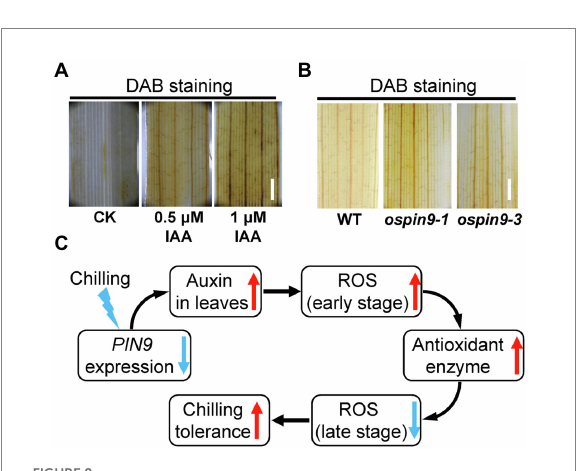
FIGURE 8 Effects of auxin application on the production of H 2 O 2 and the proposed model of OsPIN9 -mediated chilling tolerance in rice. (A) H 2 O 2 content analysis after auxin application. Bar = 1 mm. (B) H 2 O 2 content in WT and ospin9 leaves under normal conditions. Bar = 1 mm. (C) Proposed model of OsPIN9 - mediated chilling tolerance in